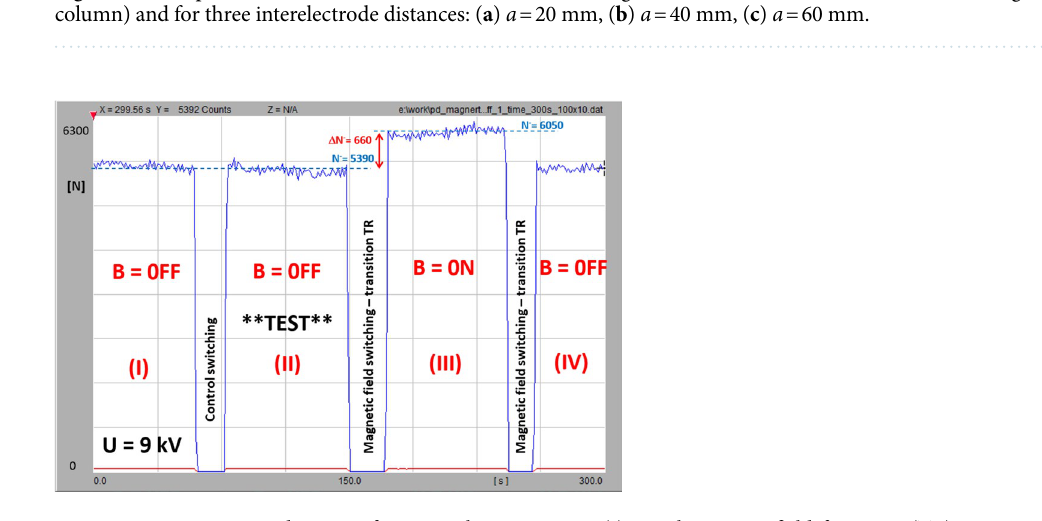
Figure 13. PD-intensity diagram of test-switching sequence: (I) initial magnetic field-free state; (TR) test turn-off switching; (II) PD recording at B = off; (TR) transition for switching on magnetic field; (III) presence of magnetic field; (TR) transition to field-free state; (IV) magnetic field